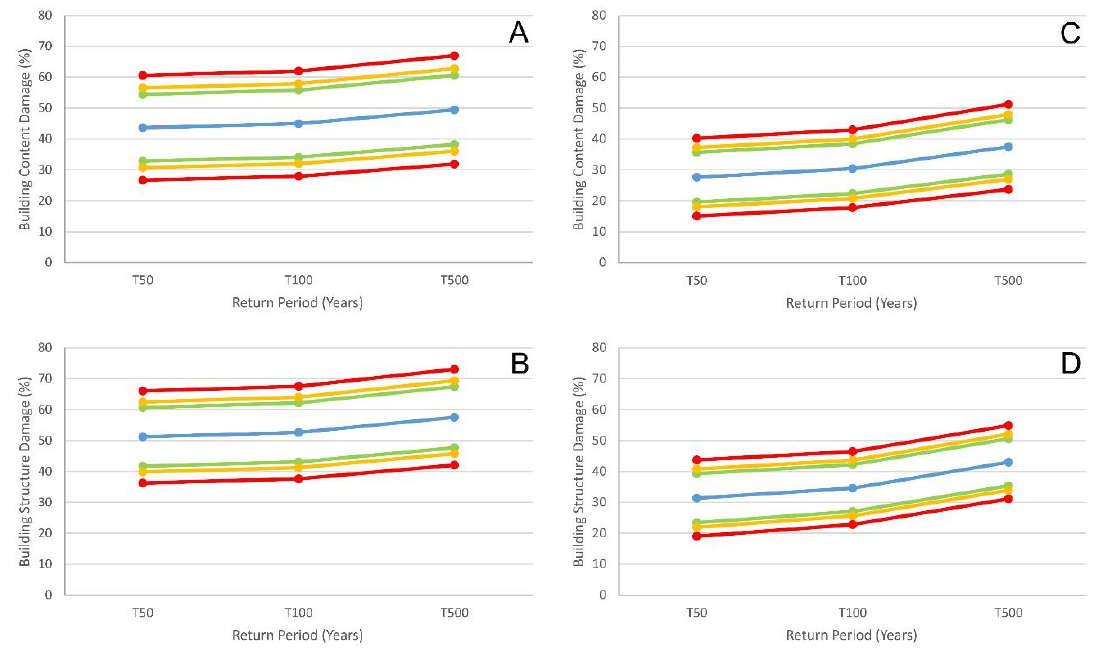
Figure 9. Average values and confidence intervals (90%: green line; 95%: yellow line; 99%: red line) for flood economic damage (%) at Navaluenga (Spain) from all magnitude–damage functions considered. Results not taking into account the topographic relationship between the main floor of the house and the surrounding land ( A and B ), and taking the topographic relationship into account ( C and D ).